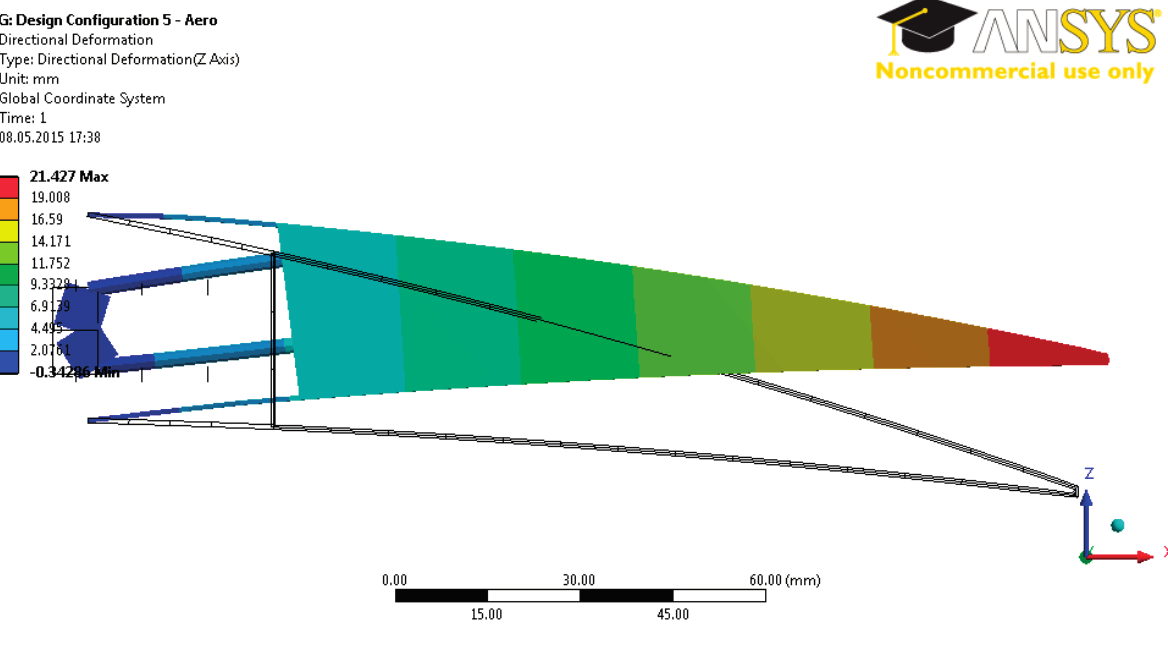
Figure 29. Direction deformation along Z -axis for design configuration 5 under aerodynamic